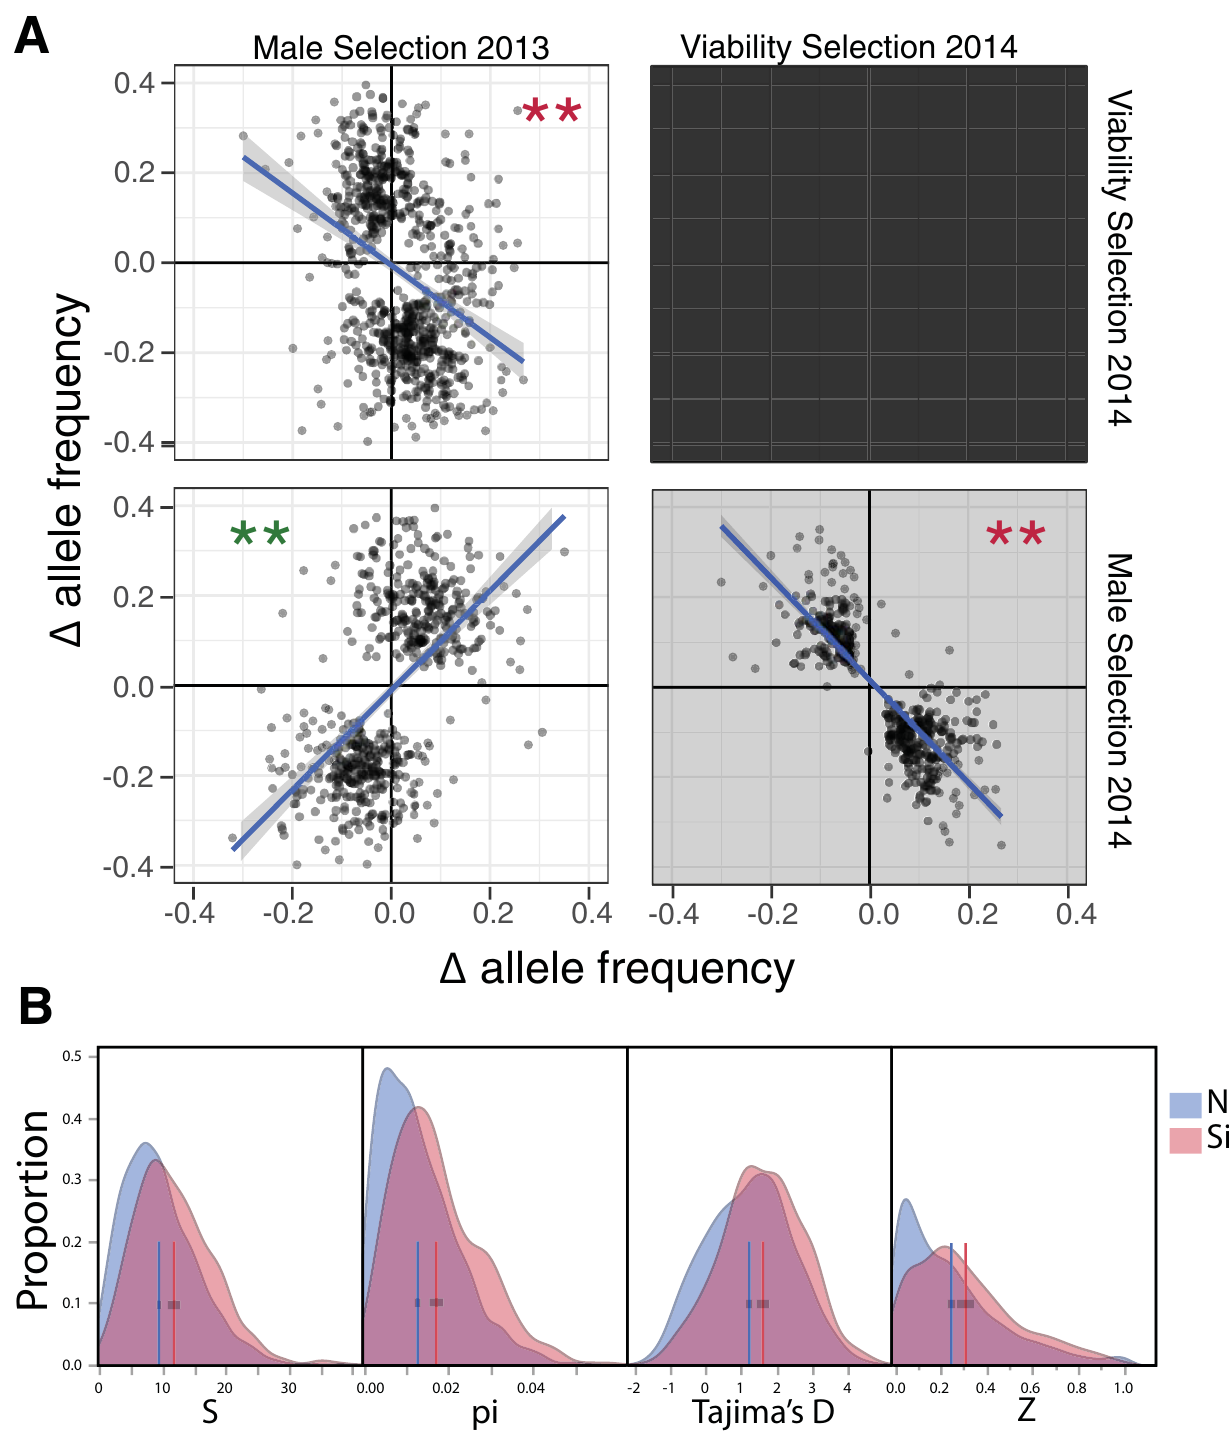
Fig 5. (A) Pairwise contrasts between predicted changes owing to male selection in 2013, viability selection in 2014, and male selection in 2014. A single SNP per gene is reported (the most significant) if p < 10 − 5 . The SNPs ascertained for contrasts are distinct from those for tests in isolation (Fig 4), although these SNP sets are overlapping (see S5 and S9 Tables). (B) Density plots for molecular test statistics are depicted for 587 selected-SNP windows and 2751 control windows. Vertical lines are means. The number of polymorphisms (S), nucleotide diversity (pi), and Tajima’s D are based on the flanking DNA (100 bp on each side, but not including the focal SNP). Z focal is Z ns calculated by contrasting the focal SNP to all flanking